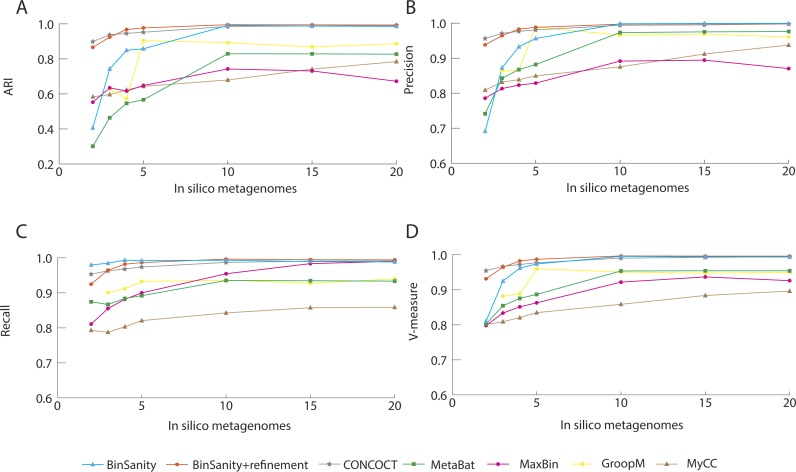
Statistical calculations (bin_evaluation.py) showing Adjusted Rand Index (A), Precision (B), Recall (C), and V-Measure (D) for diverse-mixture-2.